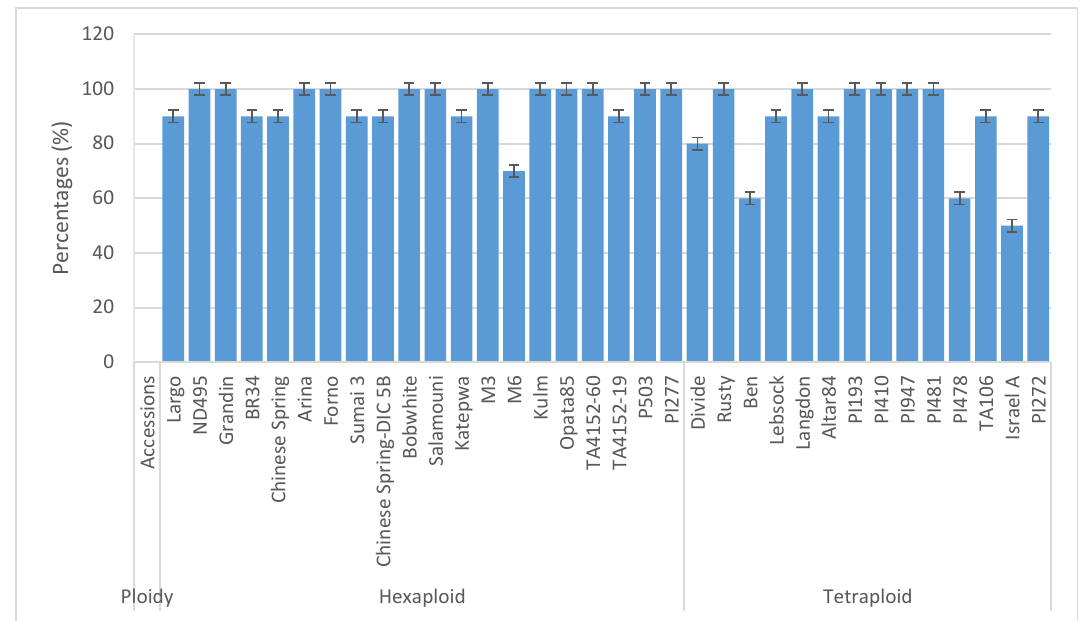
Figure 5. Germination potential for each accession.